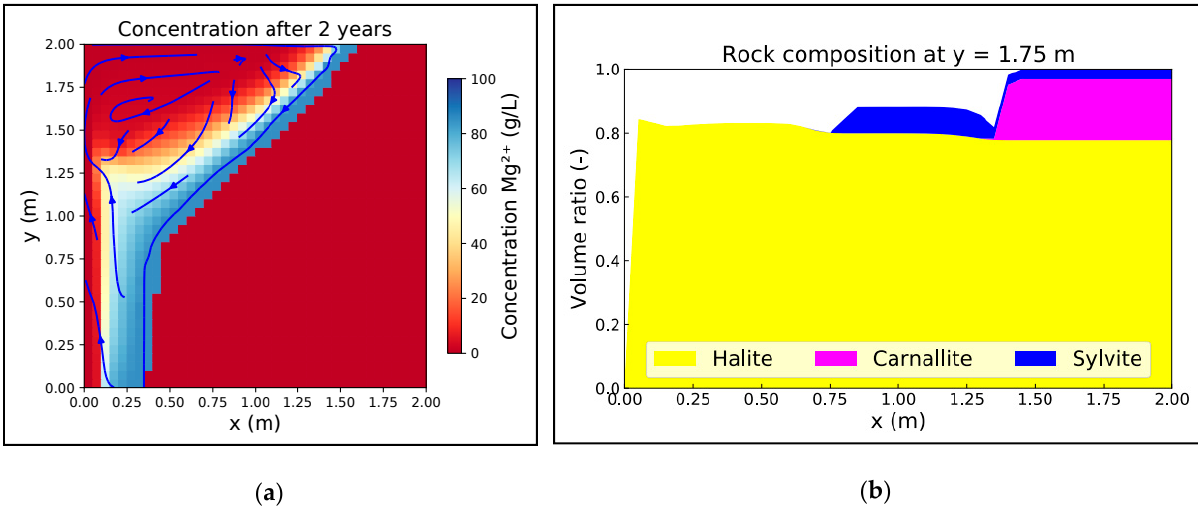
Figure 11. ( a ) Mg 2+ concentration distribution and ( b ) mineralogy for a transport- and advection- dominated system (scenario: dissolution rate 10 − 4 cm/s and 15 wt.% carnallite).